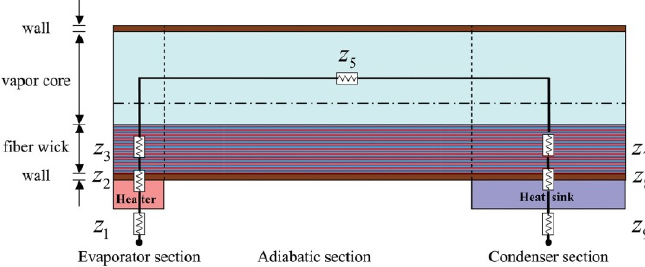
Figure 17. Mechanism of operation of a fluted flat heat pipe [83].